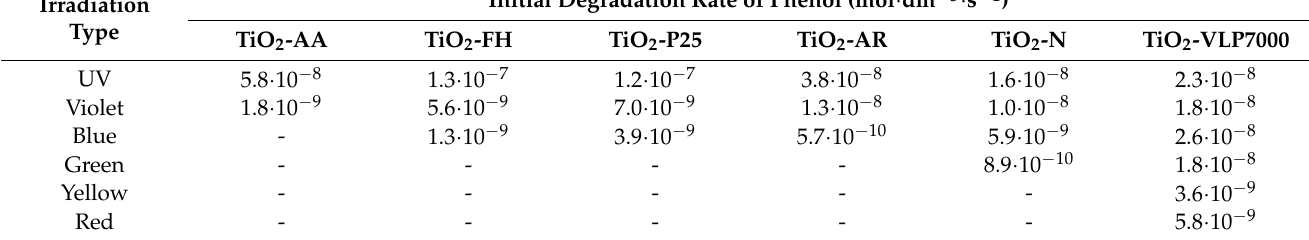
Table 1. Initial degradation rate of phenol (mol · dm − 3 · s − 1 ) for different photocatalysts under different